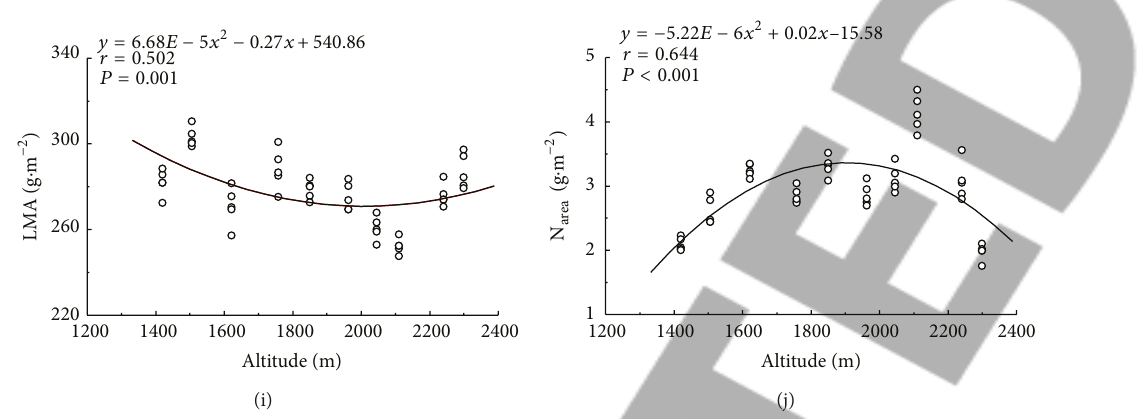
Figure 1: Variation in (a) leaf stable carbon isotope composition ( 𝛿 13 C), (b) leaf projected area per 100 needles (LA), (c) stomatal density (SD), (d) leaf nitrogen concentration per unit mass (LNC), (e) leaf phosphorus concentration per unit mass (LPC), (f) leaf potassium concentration per unit mass (LKC), (g) pigment contents (Chla + b), (h) leaf dry matter content (LDMC), (i) leaf mass per unit area (LMA), and (j) leaf nitrogen concentration per unit area (N area ) in P. schrenkiana var. tianschanica along the altitudinal gradients.